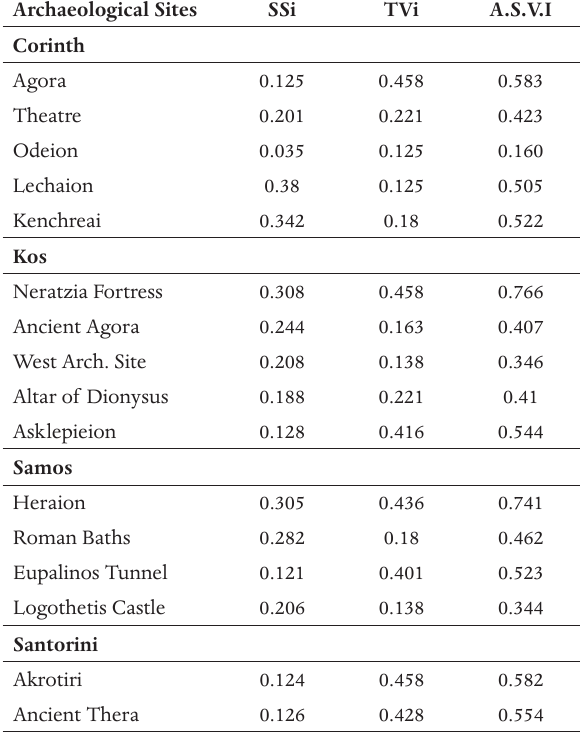
Table 6. Archaeological Site Vulnerability Index (A.S.V.I.)scores for the sites under